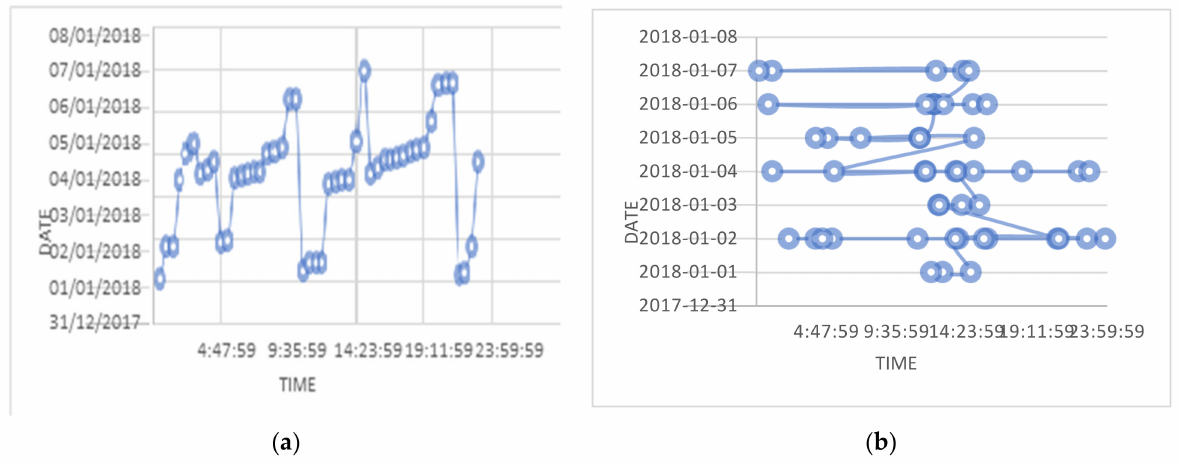
Figure 8. ( a ) Temporal activity graph for the subject. ( b ) Temporal activity graph for one of the users.